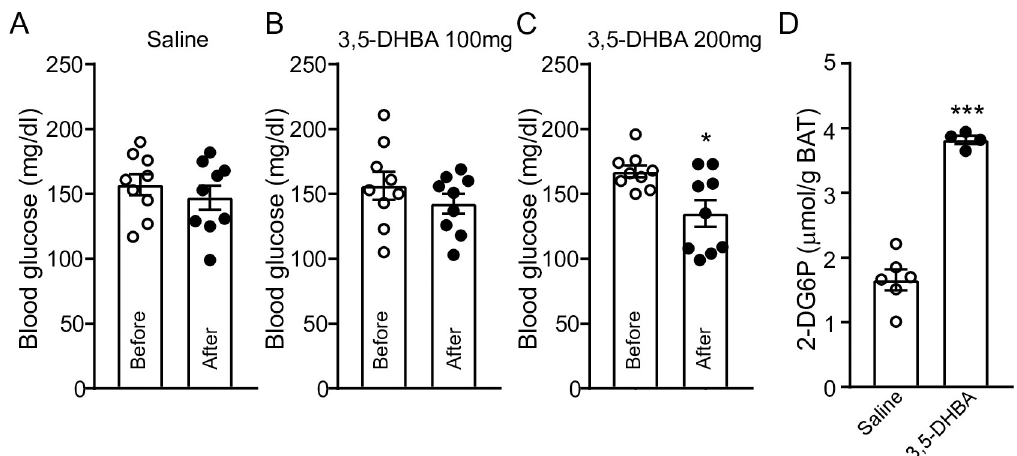
Fig 3. Acute effect of the HCAR1 agonist on blood glucose levels. A-C . Summary plot showing effect of 3,5-DHBA (0, 100, and 200 mg/kg) on blood glucose concentrations (n = 9 mice, respectively) (before: before i.p. injection of 3,5-DHBA, after: 4 hr after i.p. injection of 3,5-DHBA). Male DOI mice that were purchased from the Jackson lab were used for these experiments. � p < 0.05 D . Plot showing effect of 3,5-DHBA (200 mg/kg) on 2-DG uptake by BAT of male DIO mice (n = 6 and 4 mice, respectively). ��� p <